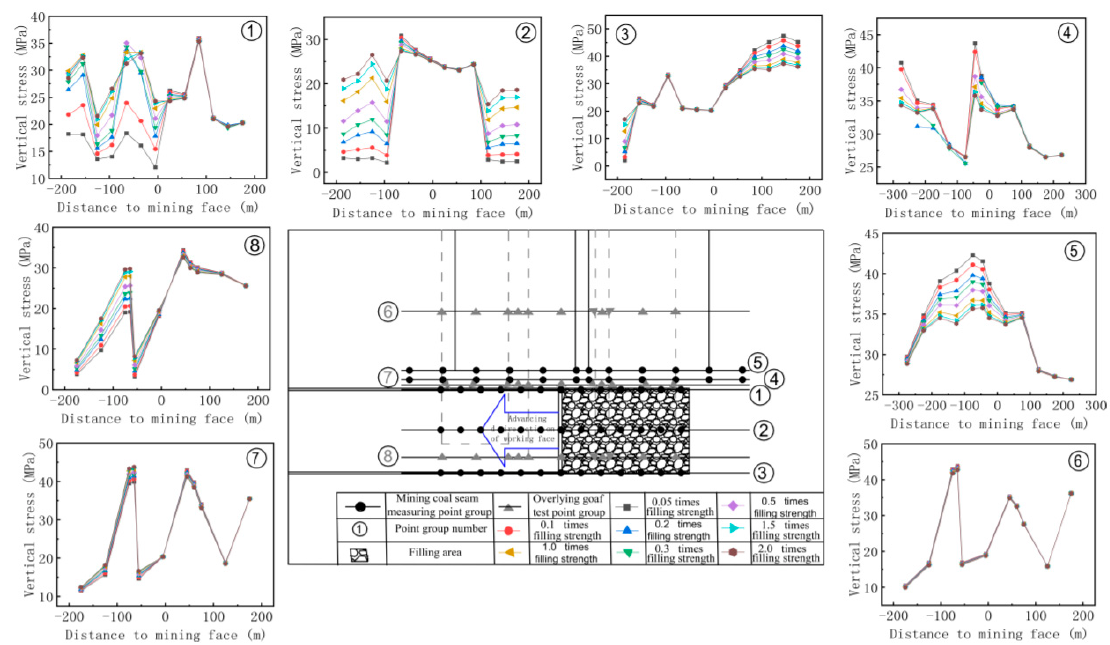
Minerals 2018 , 8 , x FOR PEER REVIEW Figure A5. Distribution of the underground pressure (180 m). Figure A5. Distribution of the underground pressure (180 m).